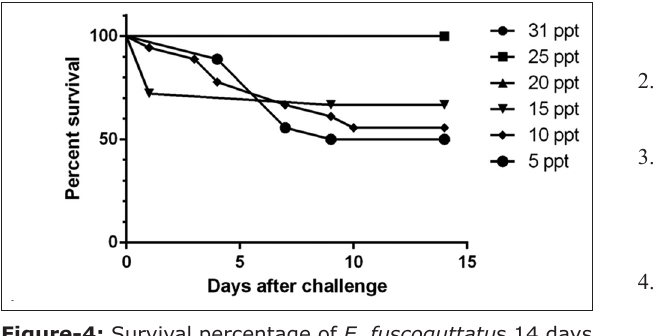
Figure-4: Survival percentage of E. fuscoguttatu s 14 days post challenged with different